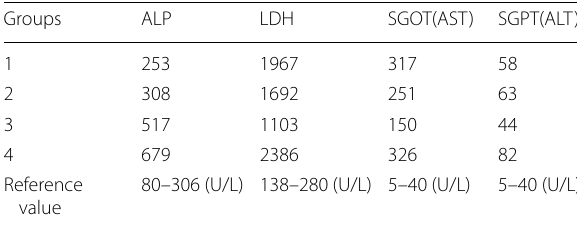
Table 3 Liver enzymes changes in the acute toxicity test